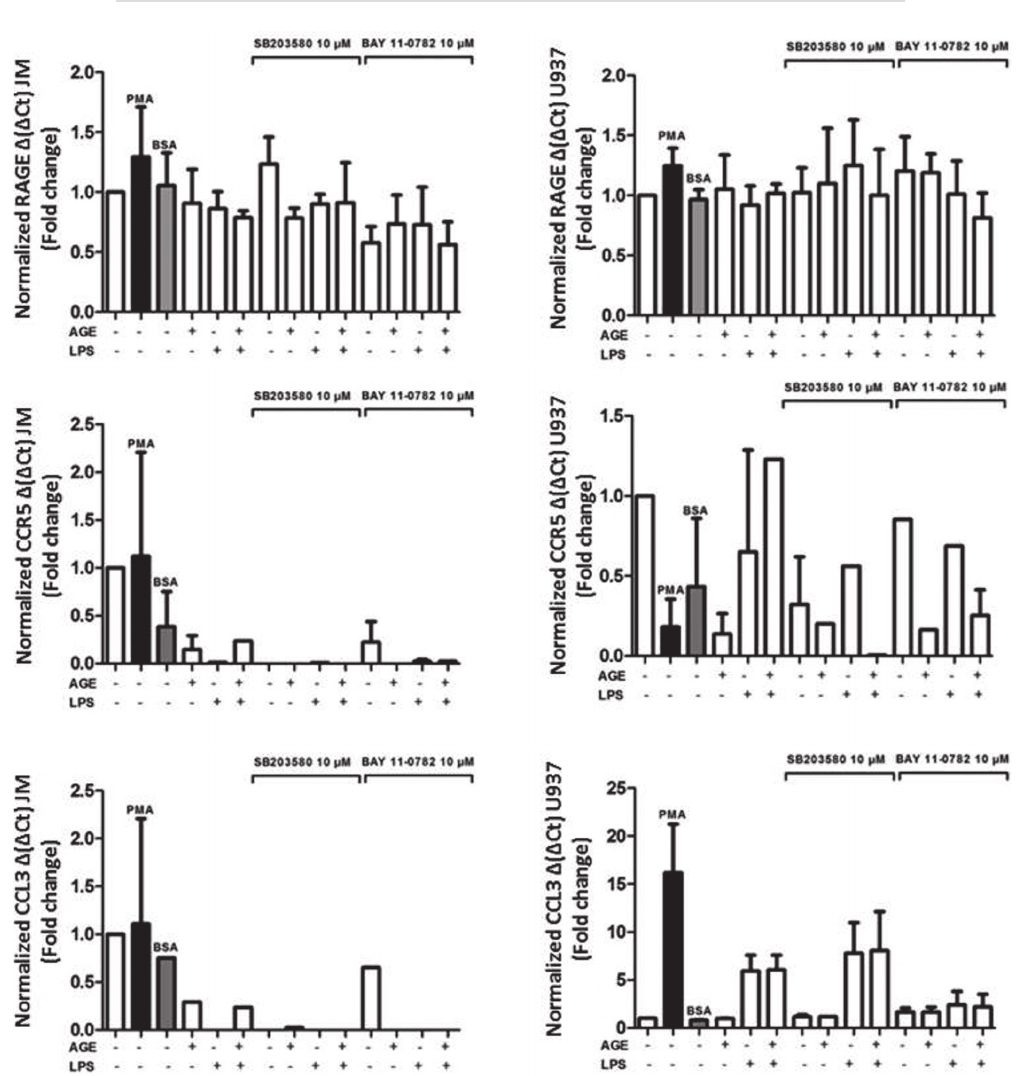
Figure 4- Gene expression (mRNA) for RAGE, CCR5 and CCL3 evaluated by RT-qPCR on cell lines of human T lymphocytes (JM) and monocytes (U937) after a 6-hour stimulation with E. coli LPS (100 ng/mL) with or without AGE-BSA (200 ug/mL) in the presence and absence of p38 MAPK (SB203580) and NF-kB (Bay 11-7082) inhibitors. Bars indicate mean±standard error of three independent